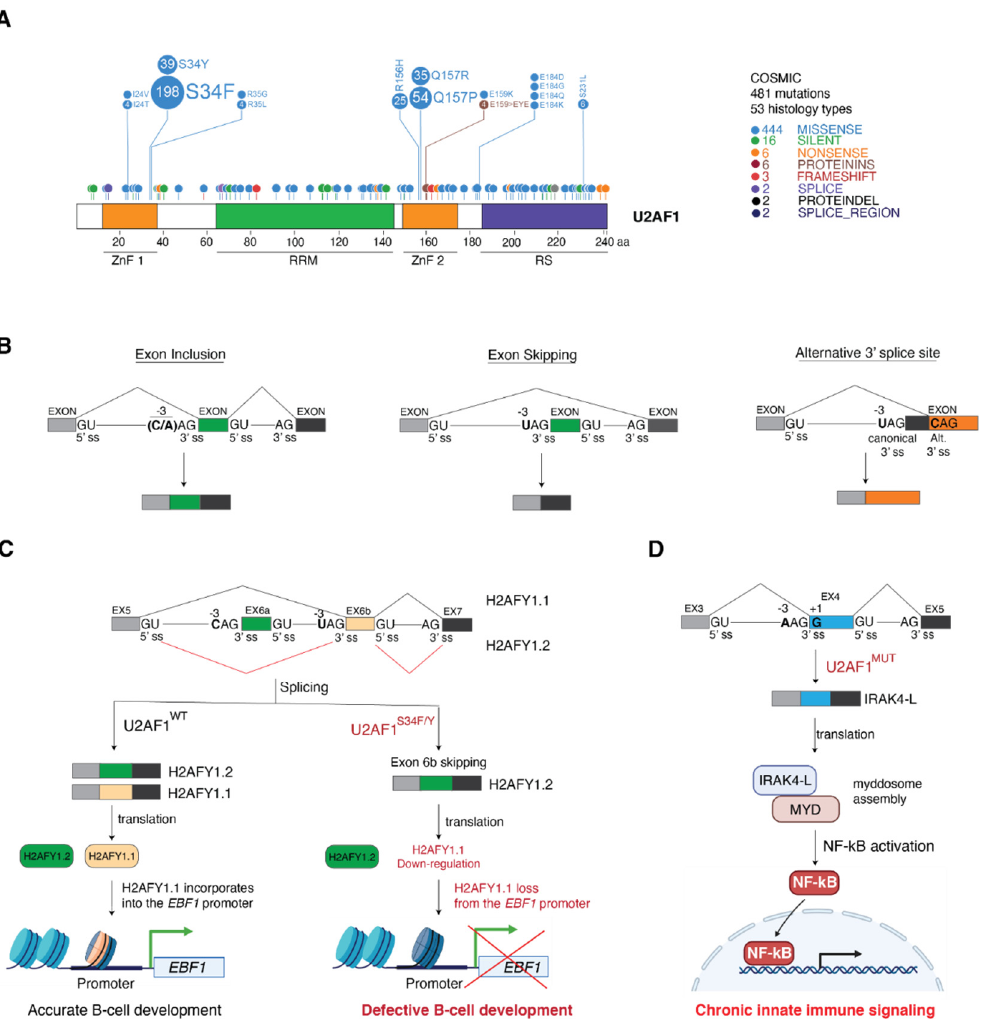
Figure 4. U2AF1 mutations influence U2AF1 3 ′ splice site recognition and splicing outcome. ( A ) Schematic representation of the U2AF1 protein with its mutation profile. U2AF1 domains are indicated: zinc finger domains 1 (ZnF 1) and 2 (ZnF 2), the RNA recognition motif (RRM) and the arginine/serine rich domain (RS). The mutation profile was obtained from the COSMIC database (https://cancer.sanger.ac.uk/cosmic, accessed on 25 October 2021) and visualized using ProteinPaint (https://pecan.stjude.cloud/proteinpaint, accessed on 25 October 2021). The number of samples harboring each mutation is indicated inside each circle and their relative abundance is represented by the disc size. ( B ) Features of splicing events affected by the S34F/Y U2AF1 mutant. Schematic exon-intron-exon regions are shown together with the characteristic sequence features present in the splicing events altered by U2AF1 S34F/Y : exon inclusion (left), exon skipping (center), and alternative 3 ′ splice site usage. The positions of the 5 ′ splice site (5 ′ ss), the canonical 3 ′ splice sites (3 ′ ss), and the alternative 3 ′ splice site (Alt 3 ′ ss) are indicated. The -3 nucleotide, which impacts on 3 ′ splice site selection by mutant U2AF1 S34F/Y , is highlighted in bold. ( C ) U2AF1 S34F/Y down- regulates the H2AFY1.1 transcript, leading to B-cell developmental defects. Schematic representation of the H2AFY pre-mRNA from exon 5 to exon 7, containing the mutually exclusive exons 6a and 6b. Splicing sequences are indicated as in ( B ). Both H2AFY isoforms are expressed in U2AF1 WT cells. In U2AF1 S34F/Y mutant cells, exon 6b is excluded; thus, H2AFY1.1 is not expressed. H2AFY1.1 loss down-regulates Ebf1 expression and leads to B-cell developmental defects. ( D ) Mutant U2AF1 up-regulates IRAK4 long isoform expression and NF-kB activation. Schematic representation of the IRAK4 pre-mRNA from exon 3 to exon 5, containing the alternative splice exon 4. Splicing sequences are indicated as in ( B ). The +1 G base is indicated in bold. IRAK4-L promotes the myddosome complex (MYD) assembly and activates NF-kB